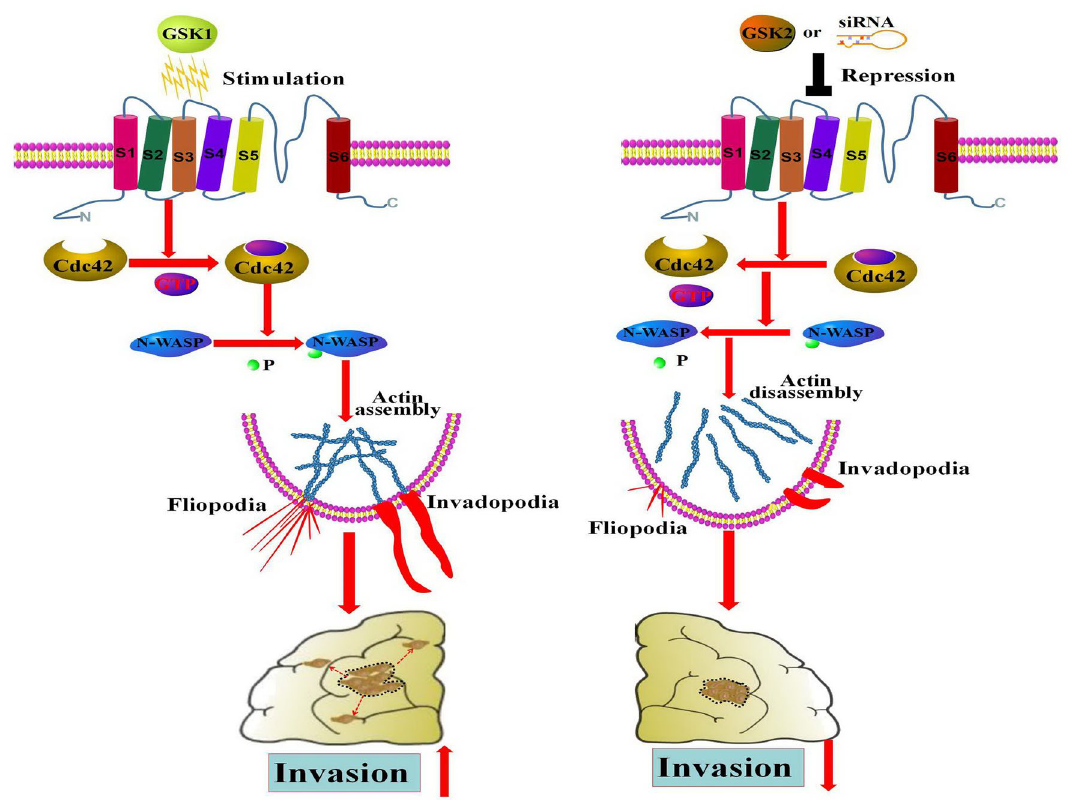
Figure 8. Schematic model: TRPV4 promotes protrusions (invadopodia and filopodia) formation and invasion through the Cdc42/N-wasp axis in glioblastoma. The schematic model was drawn with pathway builder 2.0